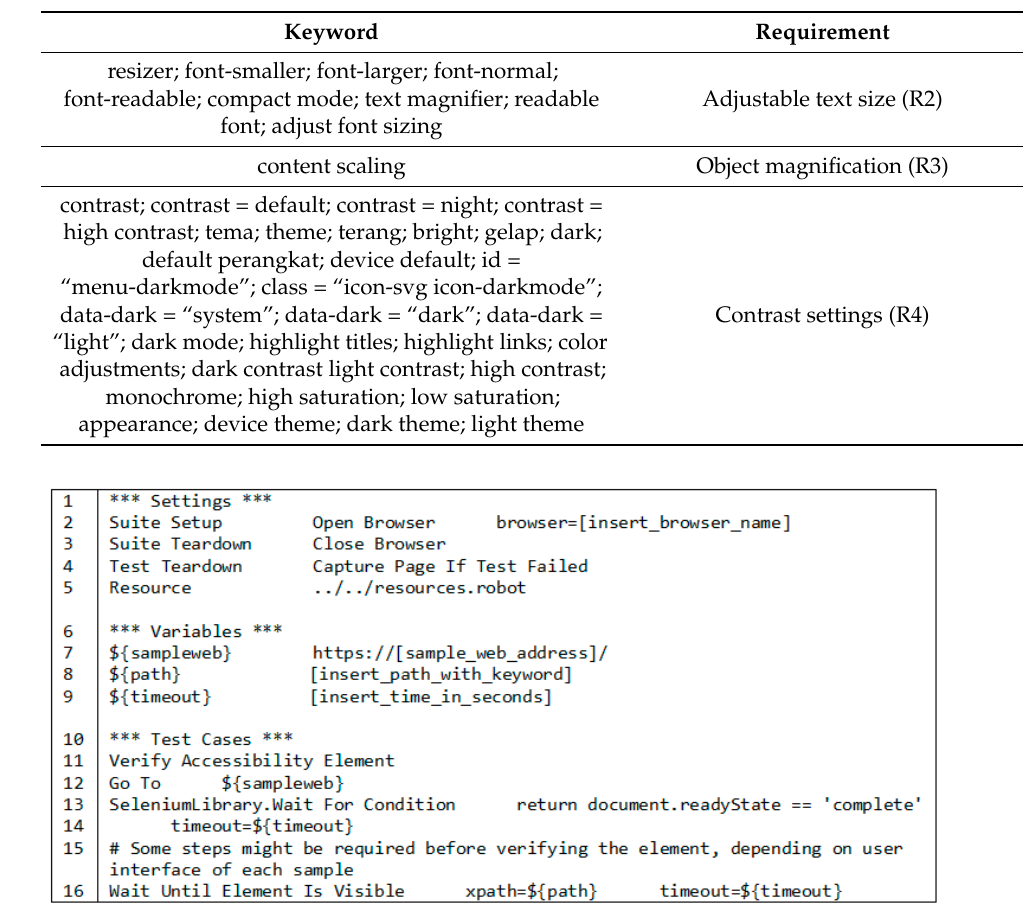
Figure 2. Automation script.